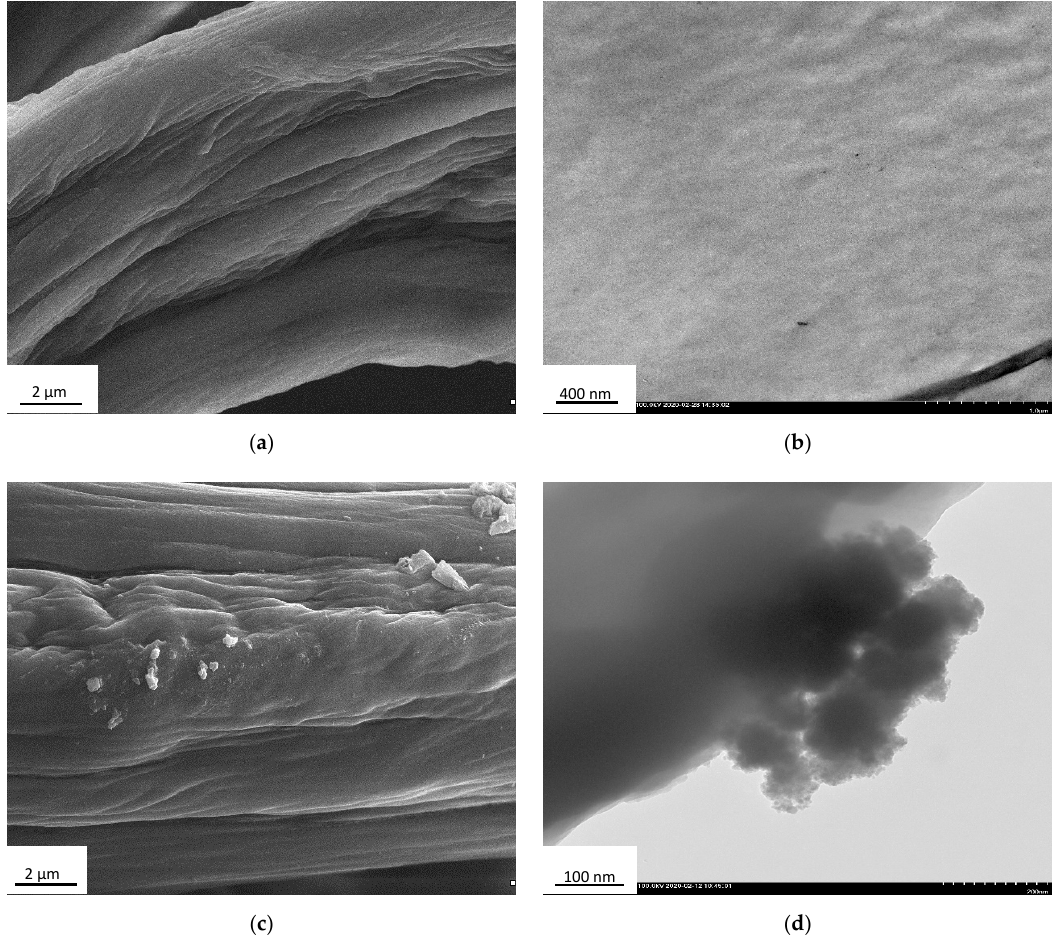
Figure 4. SEM and TEM images of the A. archeri sponge skeleton before ( a , b ) and after ( c , d ) laccase immobilization.